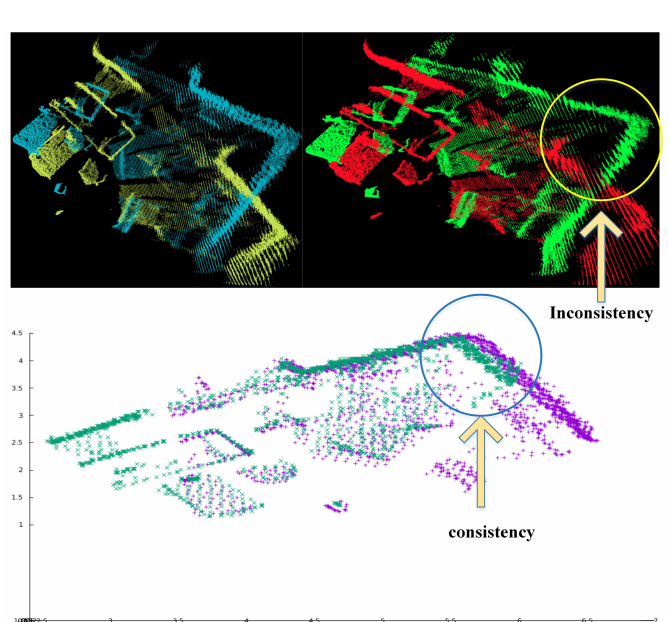
Figure 5. The Paired cloud before the ICP process ( top left ), the Paired cloud after ICP process ( top right ), and the Paired cloud after using sparse geometric feature matching method ( bottom ).